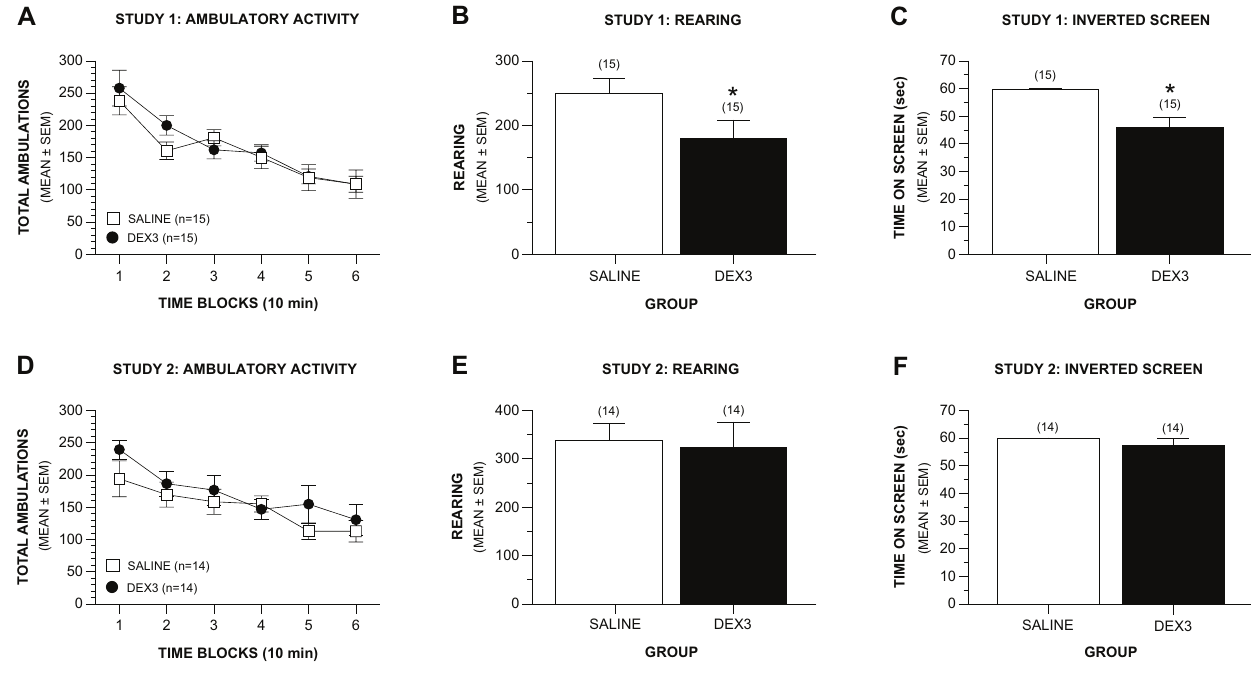
Figure 3. Early post-weaning performance of DEX3-treated and saline control mice on the 1-h locomotor activity/exploratory behavior test and battery of sensorimotor measures for Studies 1 and 2. ( A ) In Study 1, both groups exhibited similar levels of ambulatory activity as indexed by total ambulations (whole body movements) across the 60 min test. ( B